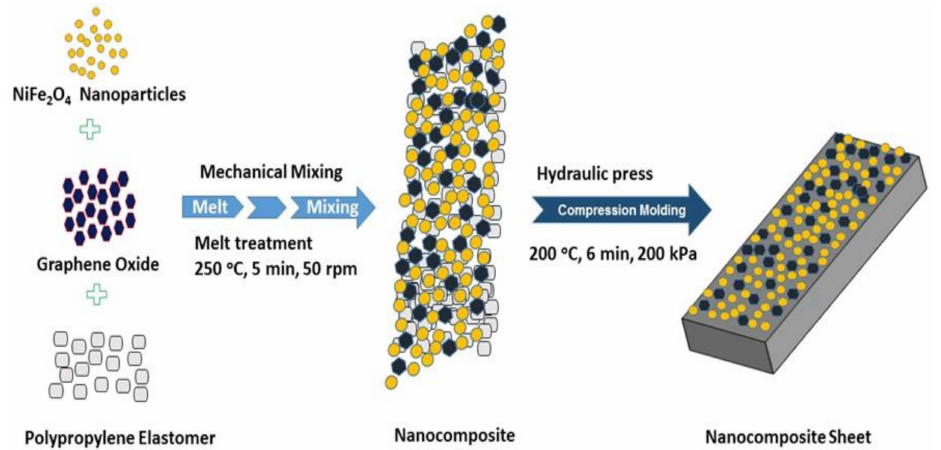
Figure 1. Schematic illustration of the preparation of polypropylene nanocomposites with spinel ferrite NiFe 2 O 4 nanoparticles and in-situ thermally-reduced graphene oxide.